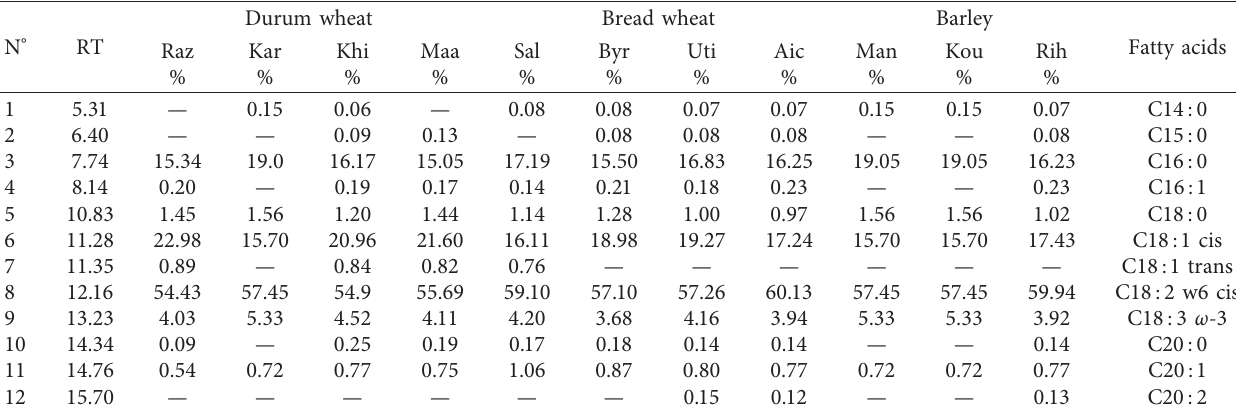
Table 4: Fatty acid composition (%: relative percent) and retention time (RT, min) of durum wheat, bread wheat, and barley varieties. N °